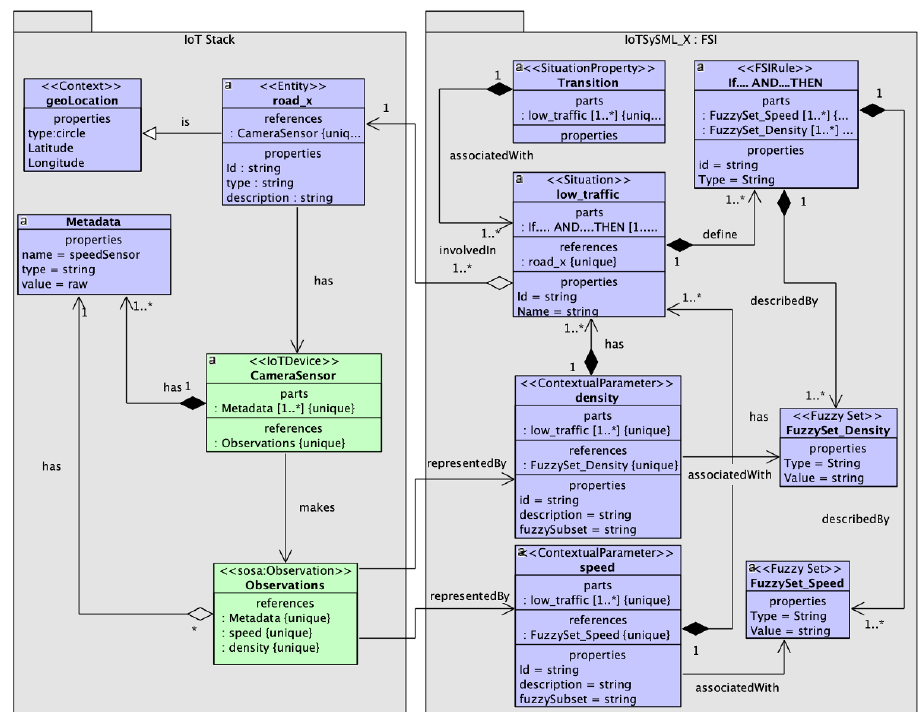
Figure 14. SySML diagram representing a Traffic Monitoring